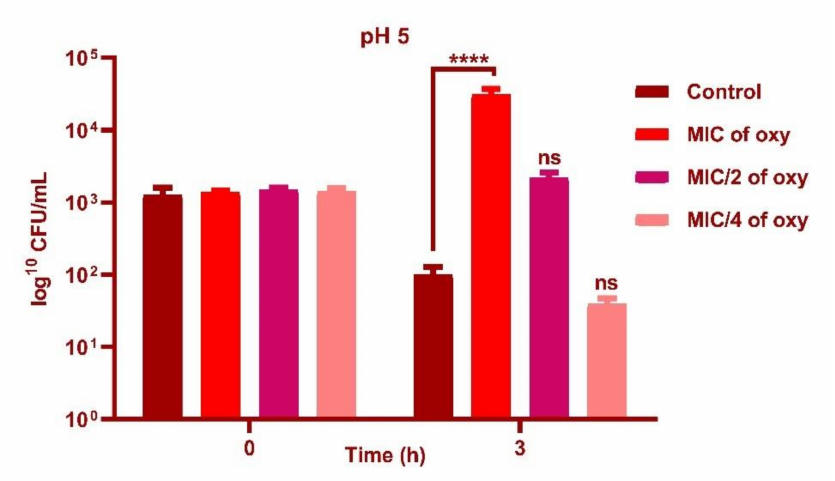
Figure 7. Viable counts (log CFU/mL) of L. fermentum ASBT-2 after 3 h of exposure to pH 5.0 with MIC, MIC/2 and MIC/4 concentrations of oxyresveratrol. **** Significantly different ( p ≤ 0.0001); ns: non-significant.